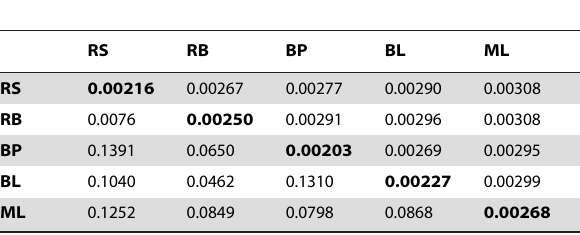
Table 2. Pairwise nucleotide diversity and population differentiation among five stickleback populations. 1